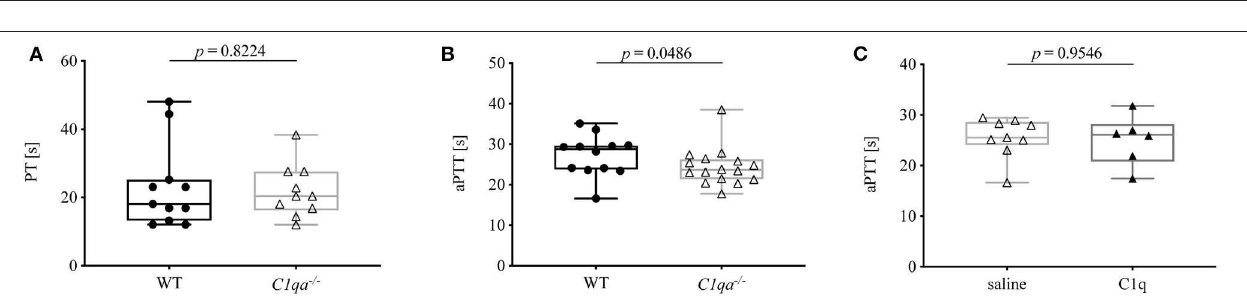
all AUCs indicate the functional responsiveness of platelets that were obtained from all three